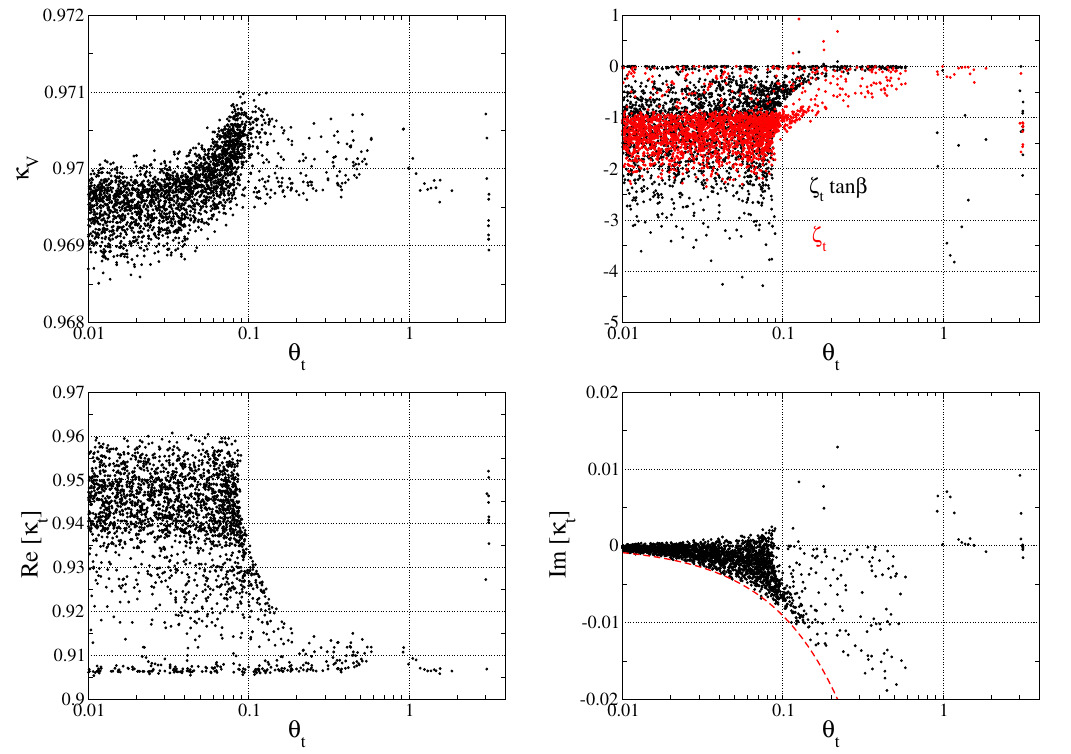
(top-left), Re [ κ ] (lower-left) and Im [ κ ] (lower-right) as functions of t t V